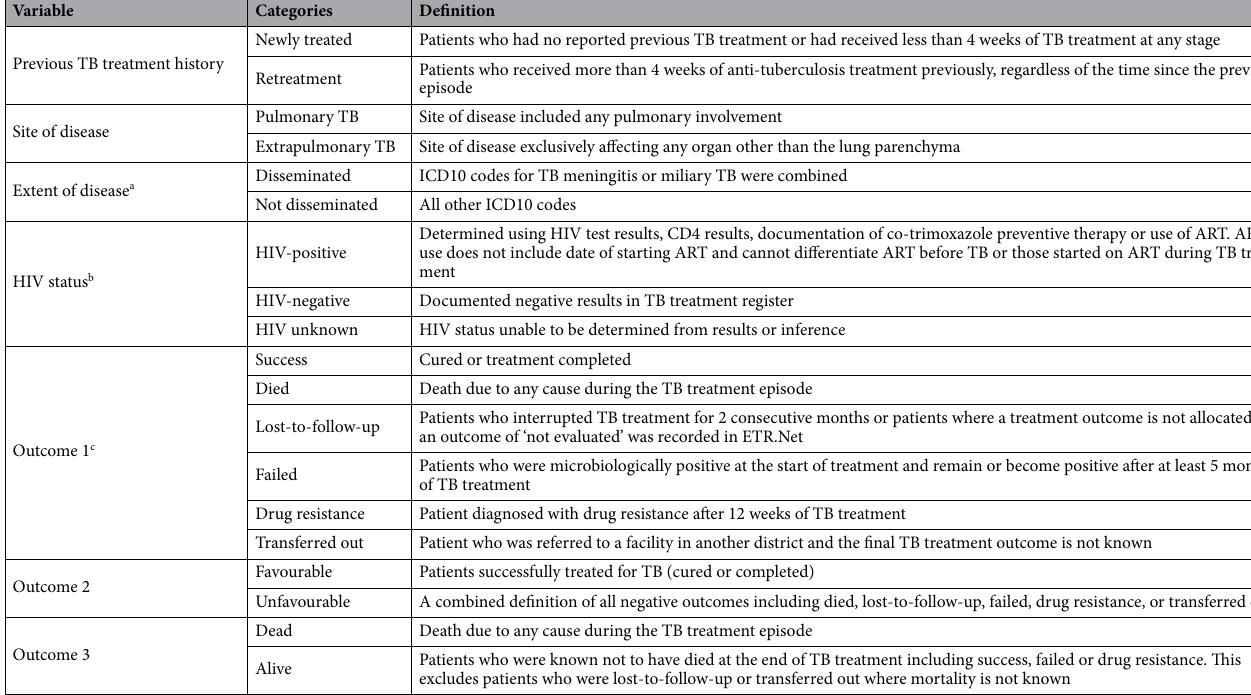
Table 1. Definitions used in the study based on variables recorded within ETR.Net and classified according to the WHO reporting framework. ART: antiretroviral therapy; ETR.Net: Electronic tuberculosis register; ICD10: International classification of disease 10; TB: tuberculosis. a Extent of disease could only be